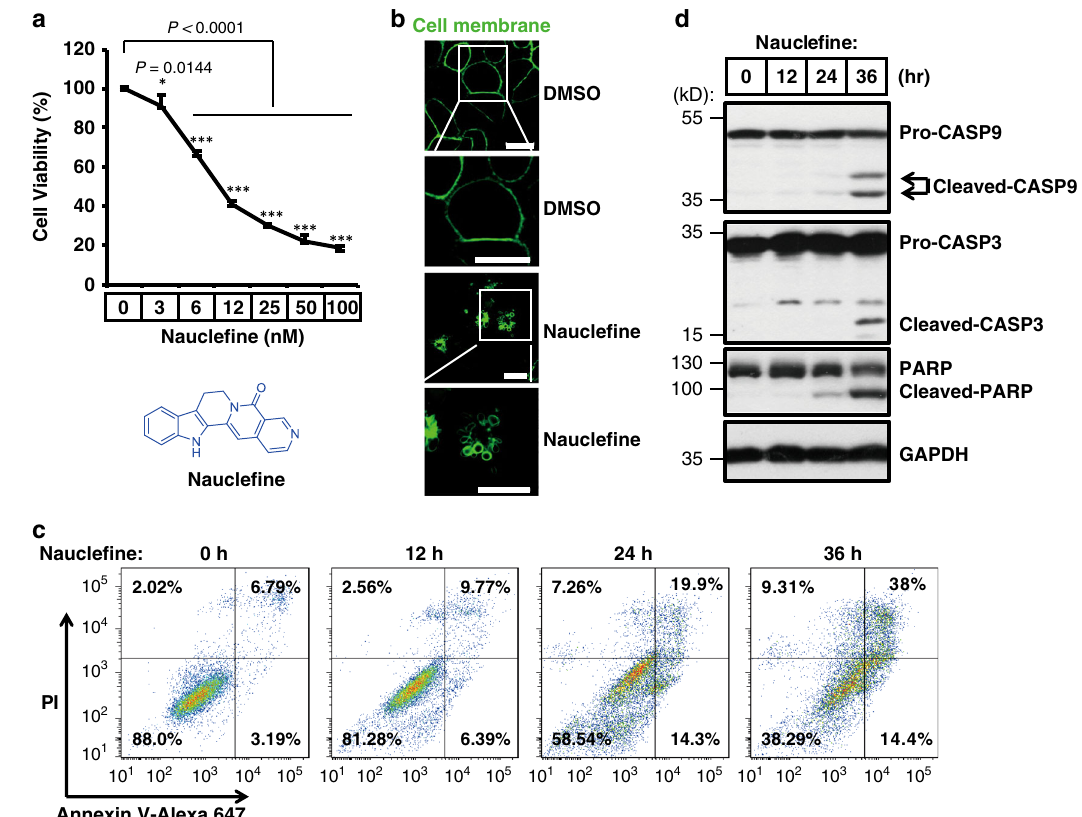
Fig. 1 Naucle fi ne induces apoptosis of HeLa cells. a HeLa cells were treated with the indicated concentrations of naucle fi ne for 48 h, then cell viability was determined by measuring the ATP level ( n = 4). The chemical structure of naucle fi ne is shown. Representative data are shown from three independent experiments (mean ± SD) and the p values from two-tailed unpaired Student ’ s t tests are indicated. * p < 0.05, ** p < 0.01, *** p < 0.001. b HeLa cells were transfected with the phospholipase C Delta 1-GFP (PLCD1-GFP) vector, then cells were treated with DMSO or naucle fi ne (200 nM). Pictures were taken under confocal microscopy. Experiments were repeated twice. Scale bars, 10 µ M. c HeLa cells were treated with naucle fi ne (200 nM) for the indicated times, then cells were stained for PI and Annexin V, and analyzed by fl ow cytometry. d HeLa cells were treated with 200 nM naucle fi ne for the indicated times, then cells were collected for western blot analysis. Western blots represent three independent